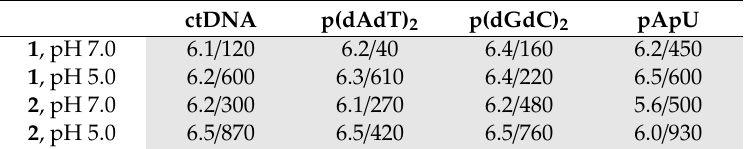
Table 2. Binding constants and spectroscopic properties of complexes ( a log K s / b Int) of conjugates 1 and 2 with ds-polynucleotides calculated by processing fluorimetric titrations ( c = 5 × 10 −7 M), at pH = 7.0 and pH = 5.0, sodium cacodylate buffer, I = 0.05 M.